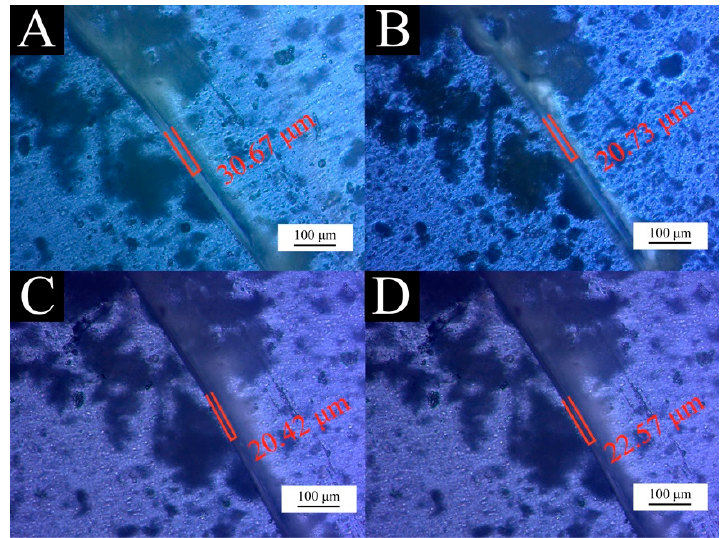
Figure 17. Scratch test diagram of waterborne coating: ( A ) 1 day, ( B ) 3 days, ( C ) 7 days, ( D ) 14 days.